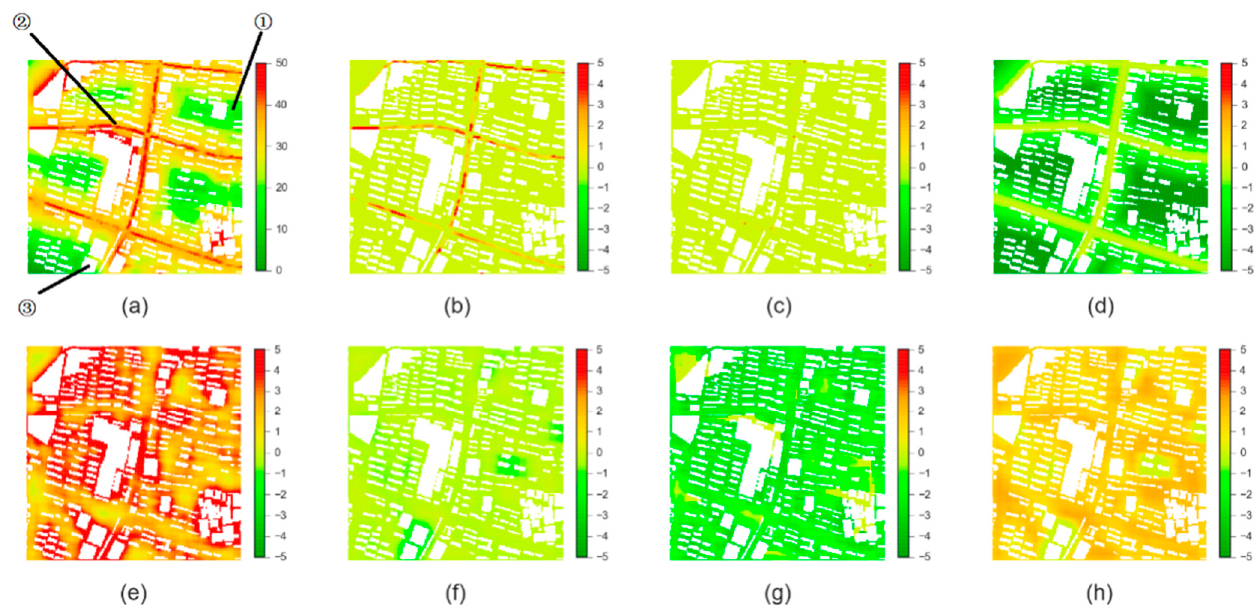
Figure 4. Contribution of different morphological indices to the UMPI. ( a ) the UMPI; ( b ) the Aspect Ratio; ( c ) the Asymmetry; ( d ) DR; ( e ) BCR; ( f ) the Rugosity; ( g ) the Occlusivity; ( h ) the Porosity.